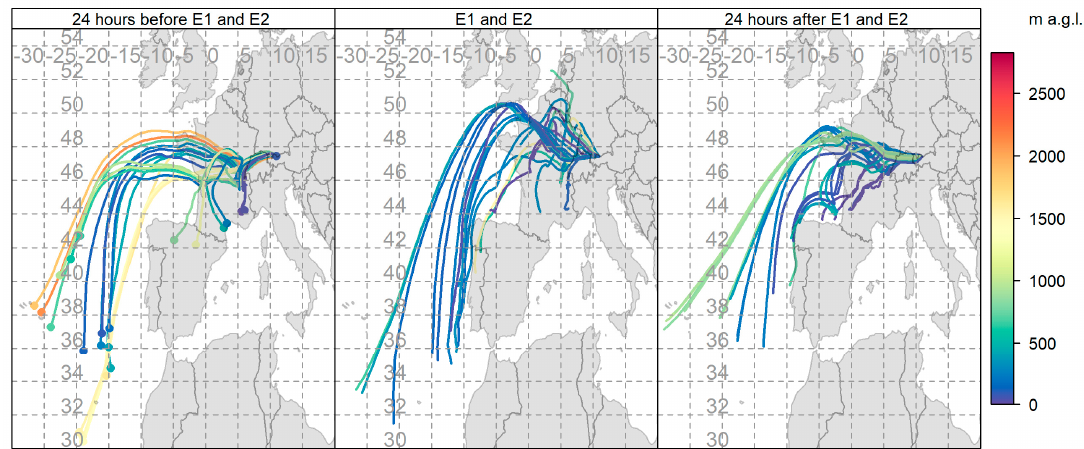
Figure 6. HYSPLIT backward trajectories (1-h interval) of air masses reaching the UFS during pollution events E1 and E2. The three plots are 24 h before the events (left panel), E1 and E2 combined during the events (middle panel), and 24 h after the events (right panel). The color of the trajectories shows the respective height above ground level (m).